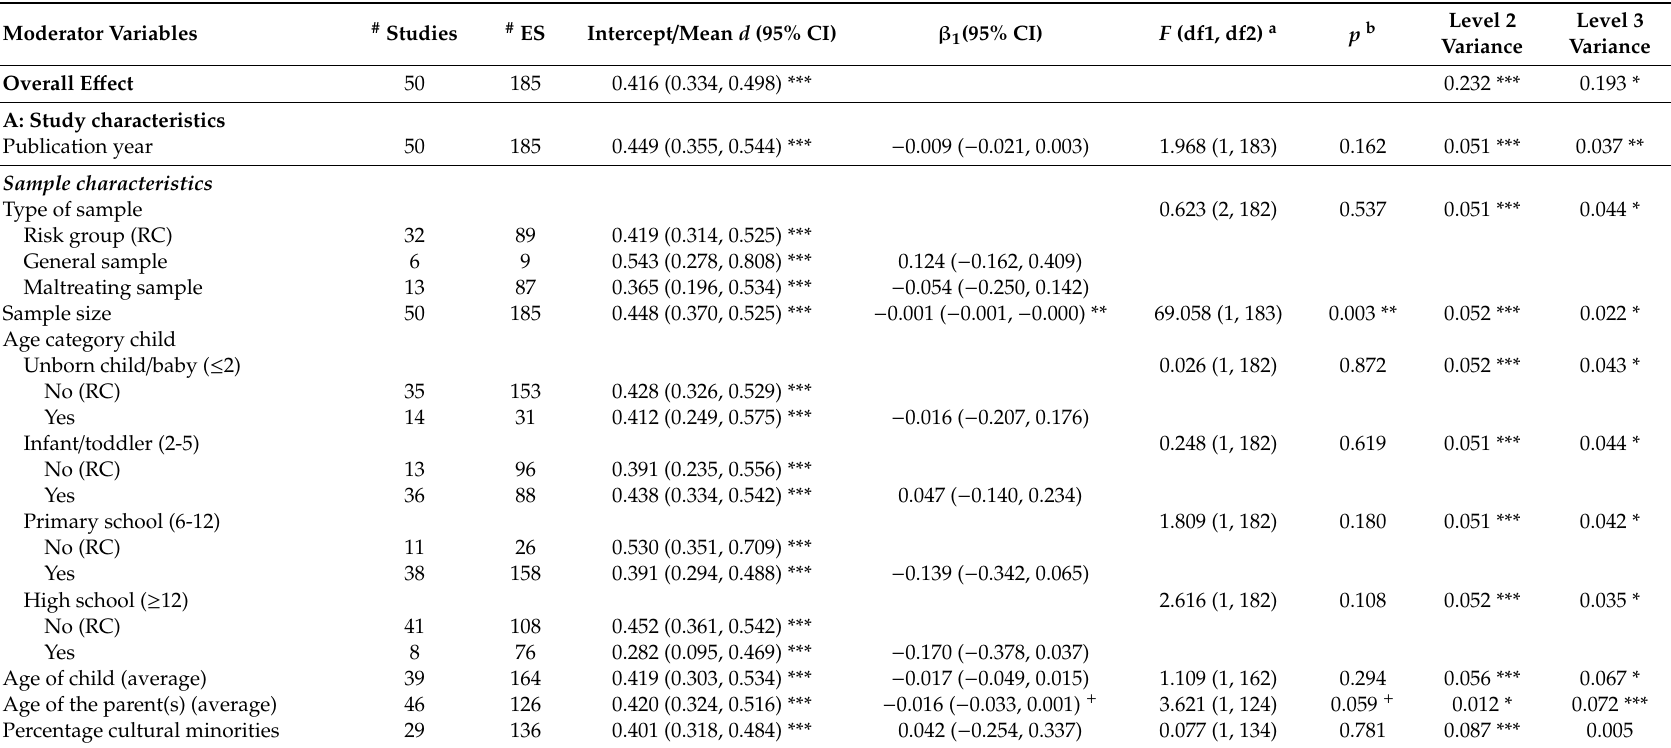
Table 3. Results for the moderator